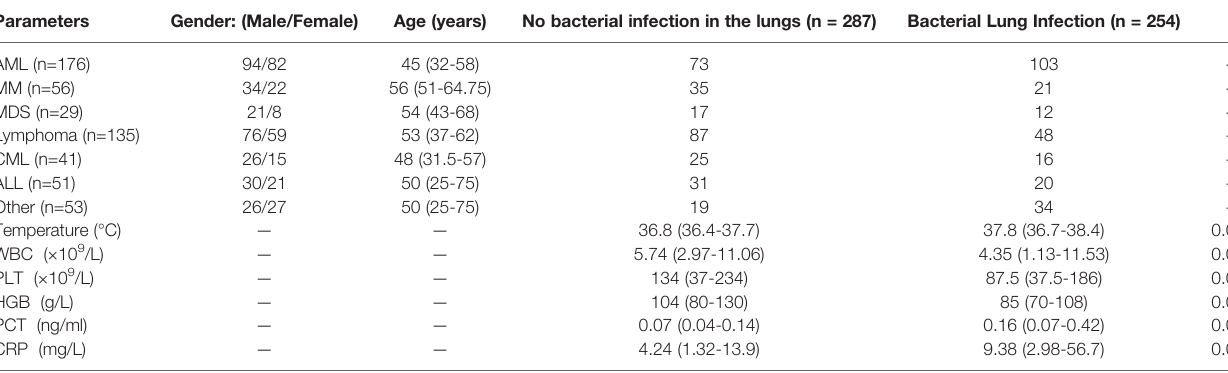
TABLE 1 | Basic characteristics of patients.